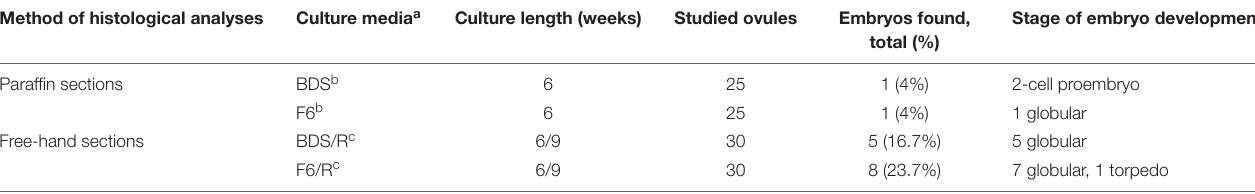
Stage of embryo development total (%)